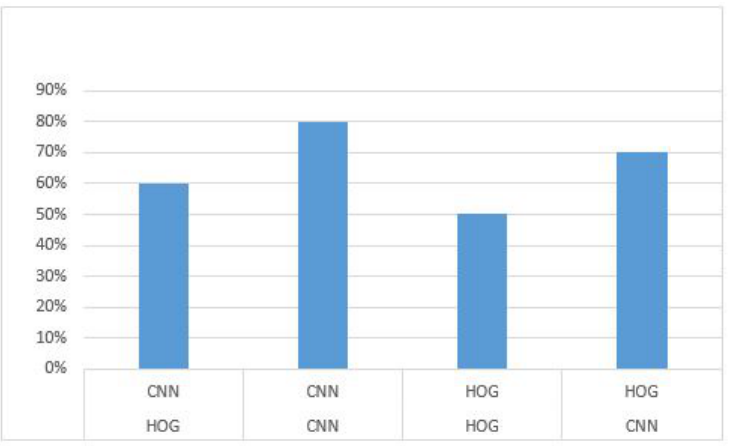
Figure 8. Results When Using a Small Duration Video as an Input to Detect Faces.